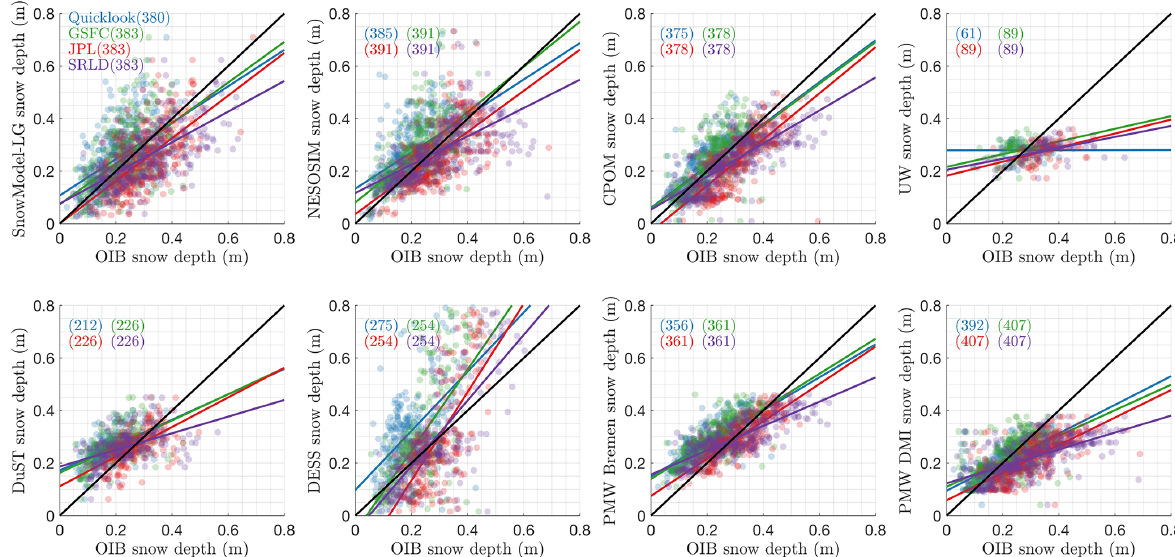
Figure 12. March and April comparison (only April in UW and March in DESS) between four monthly OIB products (quicklook in blue, GSFC in green, JPL in red and SRLD in purple) and all snow products monthly on a 100km grid for the period of 2014 and 2015. Lines are best linear fits. Numbers in left corners indicate the valid count in the linear fitting. Table 2. R 2 (in bold), RMSE (left in bracket, units: cm) and NRMSE (right in bracket) of various average monthly snow depth products in comparison with four OIB snow depth products, using a 100 × 100km monthly comparison. OIB product SnowModel-LG NESOSIM CPOM UW DuST DESS PMW Bremen PMW